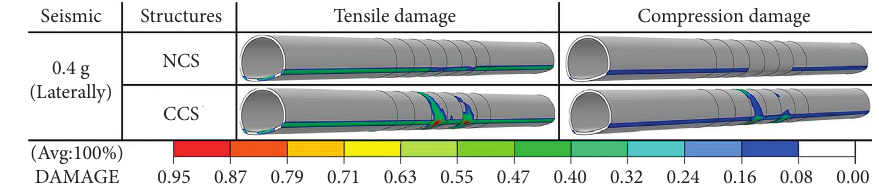
Figure 10: Lining damage distribution.